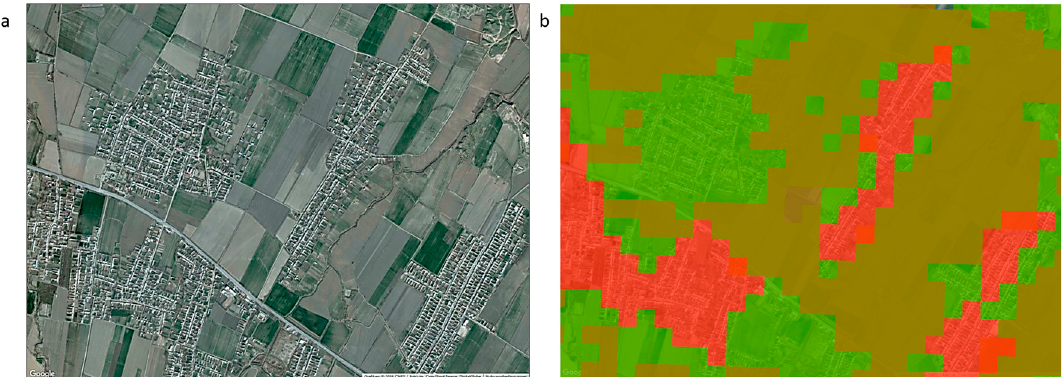
Figure 11. Illustration of the overestimation of the MR-iCE in reference site 156-32 (in CZ 6) due to an underestimated urban mask and underestimated HR-iCE (factor 1.45, see Table 3). ( a ) Very high resolution data of the subset (Google image: © 2016 CNES/Astrium, Cnes/Spot Image, Digital Globe); ( b ) the same background image overlaid with the urban mask ( red ), the HR-iCE aggregated to the MODIS pixel scale ( brown ), and the resulting MR-iCE ( green ). All except three of the aggregated HR-iCE were also mapped as MR-iCE (if the brown overlay was removed all these pixels would appear in green colors, except three).